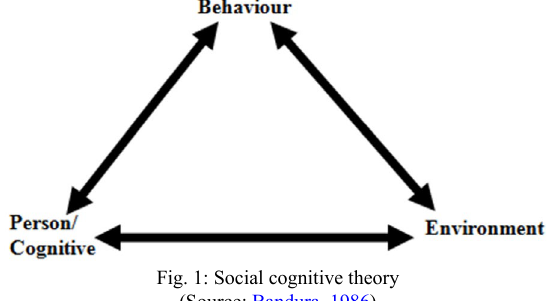
Fig. 1: Social cognitive theory (Source: Bandura, 1986)